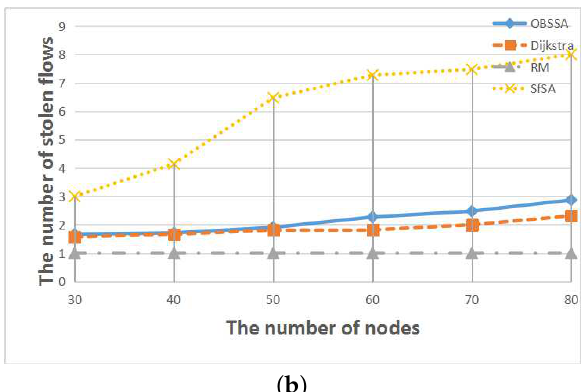
Figure 13. The relationships between the number of stolen flows and the number of flows. ( a ) F = 15, U = 0.4; ( b ) F = 15, U = 0.5.